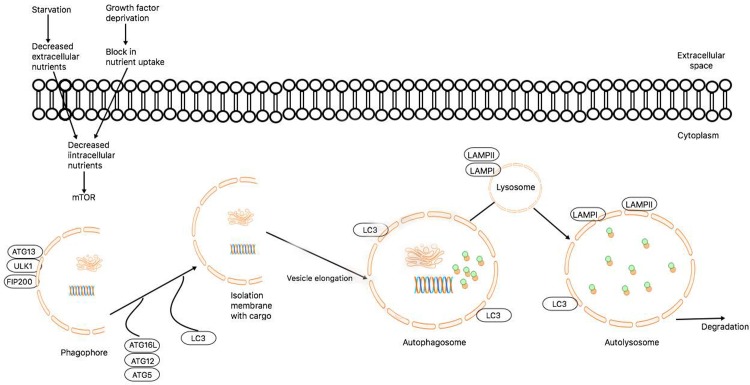
Molecular pathway of autophagy.Autophagy activation is controlled by several factors, including amino acid and nutrient deprivation, which stimulates mTOR-related pathways. Upon mTOR inhibition by starvation or rapamycin, ATG13/ULK1/FIP200 form a stable complex, essential for autophagy activity. Highly coordinated autophagy-related proteins are recruited to the phagosphore to participate in the autophagosome formation. ATG7 is one of the crucial regulators of this process. Lipidation of LC3-I known as LC3-II is attached to the autophagosome membrane and is widely used to monitor autophagy induction. When autophagosome formation is completed, the fusion between autophagosome and lysosome is mediated by lysosomal membrane protein LAMP-2. ATG12 conjugation to ATG5 is a crucial step in autophagosome formation. ATG7 regulates ubiquitin-like reaction that mediates this mechanism and subsequent processes in the autophagy machinery.